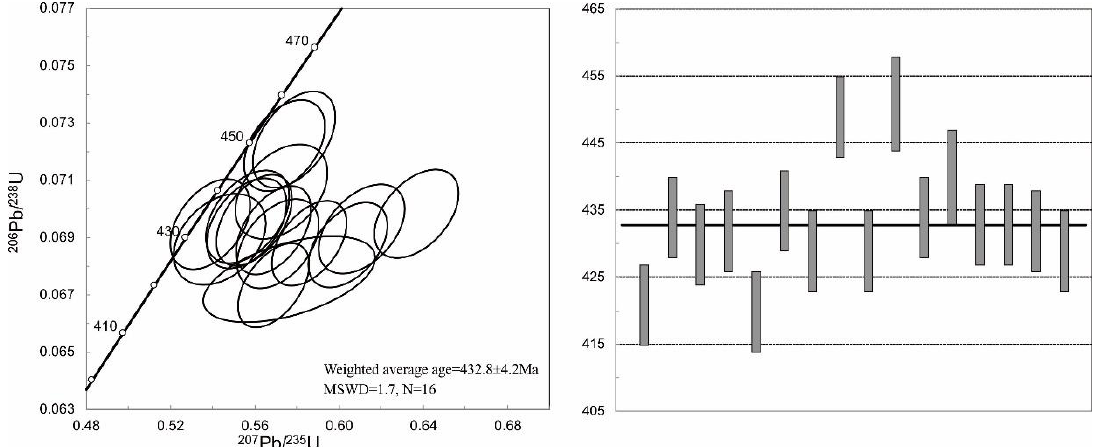
Figure 9. Zircon U-Pb Concordia ages diagram of the mafic enclaves in the Qingshanbao complex. Minerals 2019 , 9 , x FOR PEER REVIEW